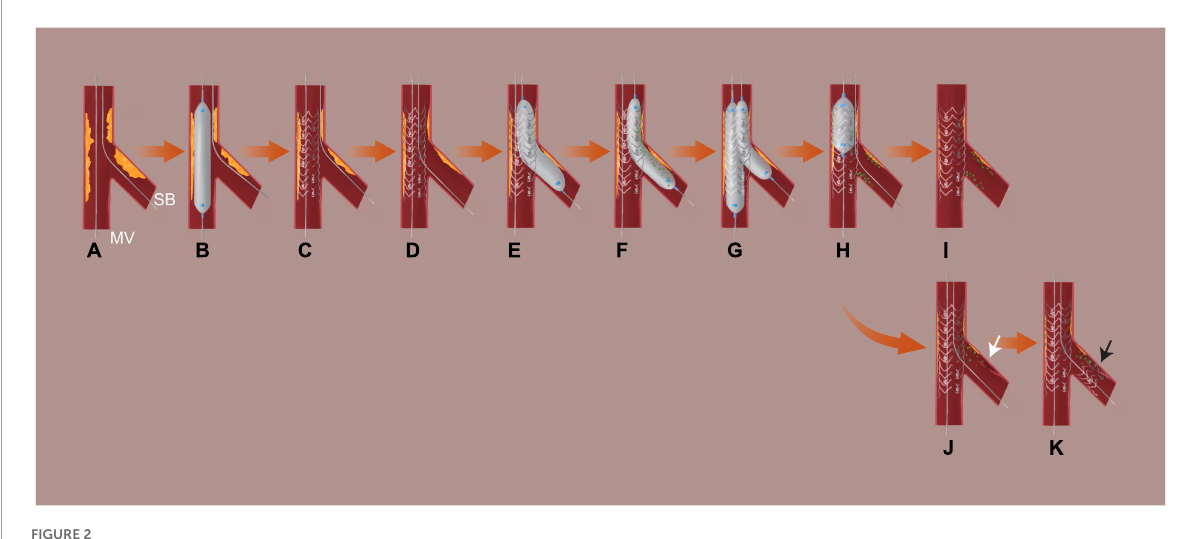
FIGURE2 Procedural steps in DCB group. (A) Wiring both branches; (B) MV lesion preparation; (C) MV stent implantation; (D) rewire SB from the distal strut; (E) SB lesion preparation: plaque modification and expand the orifice of SB; (F) SB DCB angioplasty; (G) final kissing inflation; (H) POT if necessary; (I) final result I; (J) dissection ( ≥ type C or flow-limited, white arrow); (K) bailout stent deployment (black arrow, the distance between the proximal end of the stent and the ostium of the vessel ≥ 3 mm) and final result II. MV, denotes main vessel; NC, non-compliant; SB,